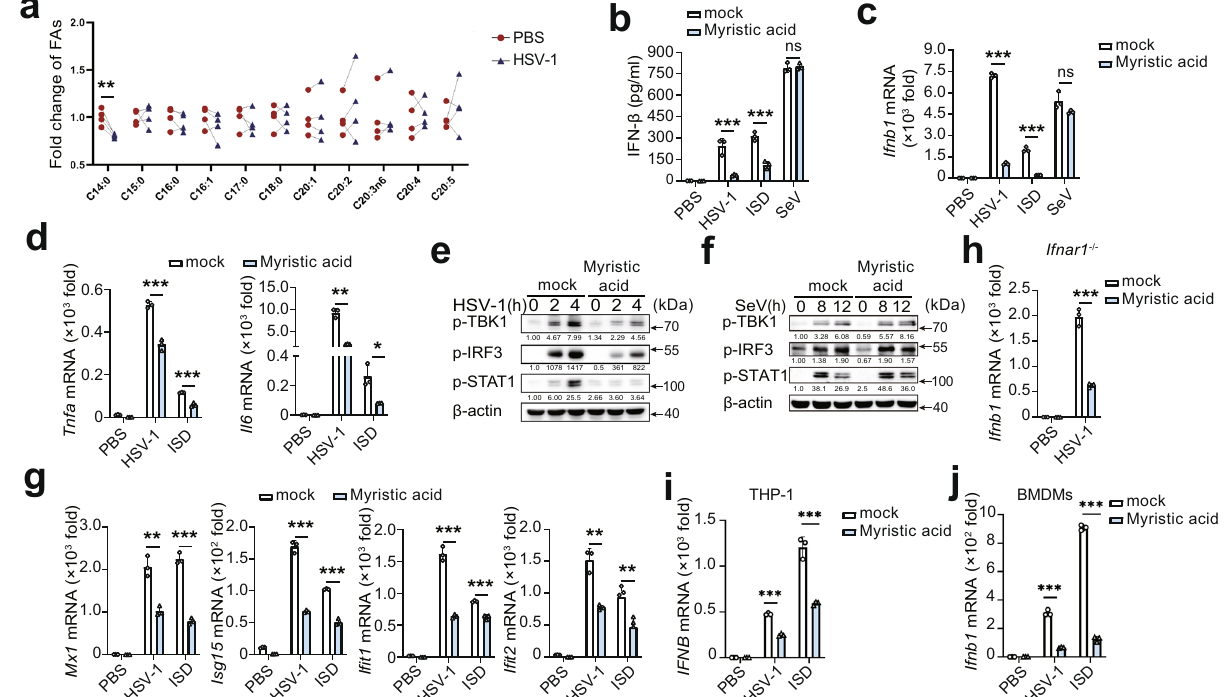
Fig. 1 | Myristic acid inhibits cGAS-dependent antiviral immune responses. a Fold changeof saturatedfattyacids(SFAs),determined bygaschromatographyin primary mouse peritoneal macrophages (PMs). Statistical signi fi cance was deter- mined by paired two-sided multiple Student ’ s t-tests, n =4 biologically indepen- dent samples. b – d Enzyme-linked immunosorbent assay (ELISA) analysis of interferon(IFN)- β secretion( b )andquantitativepolymerasechainreaction(qPCR) analysis of Ifnb1, Tnfa, or Il6 mRNA level ( c and d ) in mouse PMs pretreated with solvent (mock) or myristic acid, plus stimulation as indicated, n =3 samples examined over 3 independent experiments. e , f Immunoblot assays of p-TBK1, p- IRF3,andp-STAT1inPMspretreatedwithsolvent(mock)ormyristicacid,andthen infected with herpes simplex virus 1 (HSV-1) or Sendai virus (SeV). g qPCR analysis